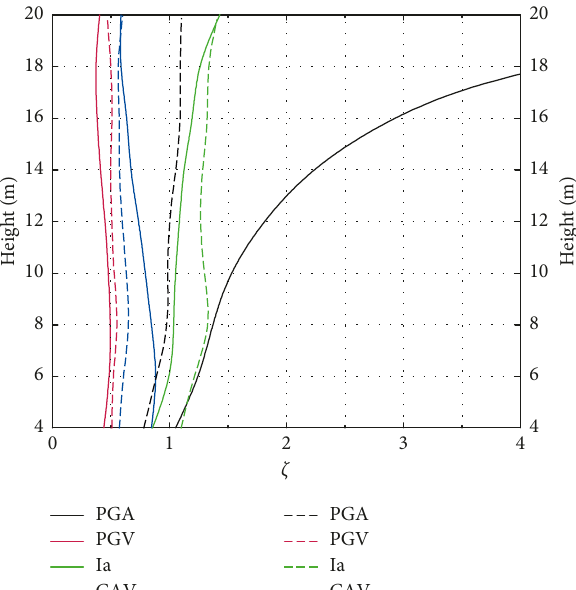
Figure 16: Proficiency comparison of IMs under pulse-like and far-field ground motions. The solid lines and dashed lines refer to the cases of pulse-like and far-field ground motions,